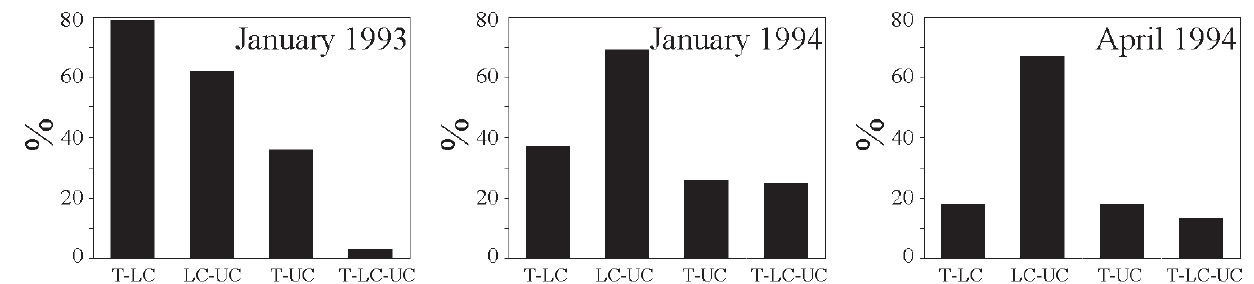
Fig. 8. Paired comparisons of species composition for the tailrace (T), lower chamber (LC) and upper chamber (UC) at different sampling periods (adapted from Espinach Ros et al., 1997).